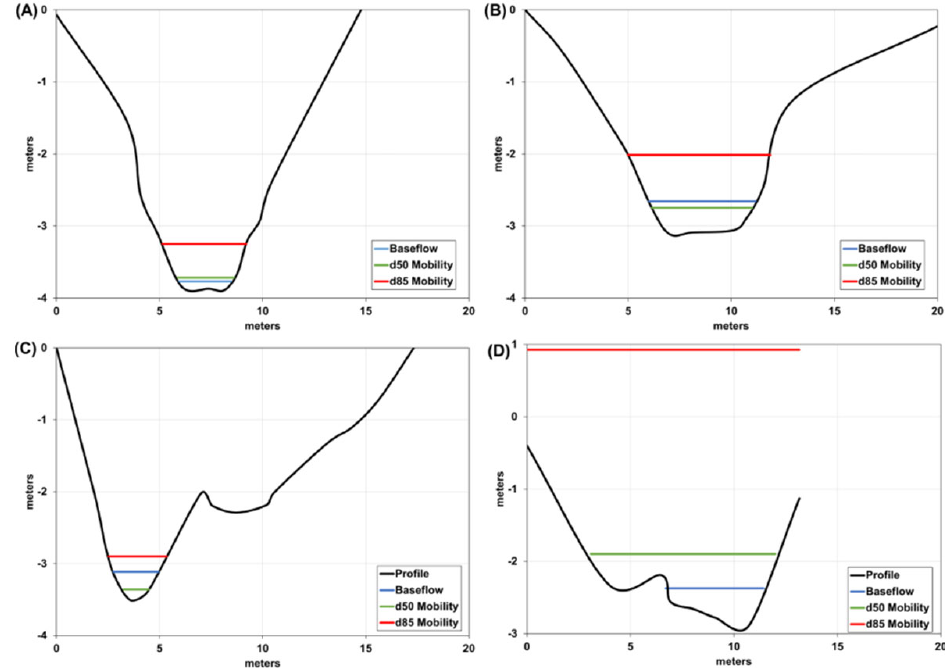
Figure 5. Representative cross-sectional for a typical riffle within each of the four streams. ( A ) 1900N; ( B ) Frog Creek; ( C ) Bray Creek; ( D ) Crooked Creek. Blue indicates baseflow gauge height; green indicates the gauge height required to mobilize d 50 sediment; red indicates the gauge height to mobilize d 85 sediment. Perspective is looking upstream for each cross-section. Vertical Exaggeration = 4.7.